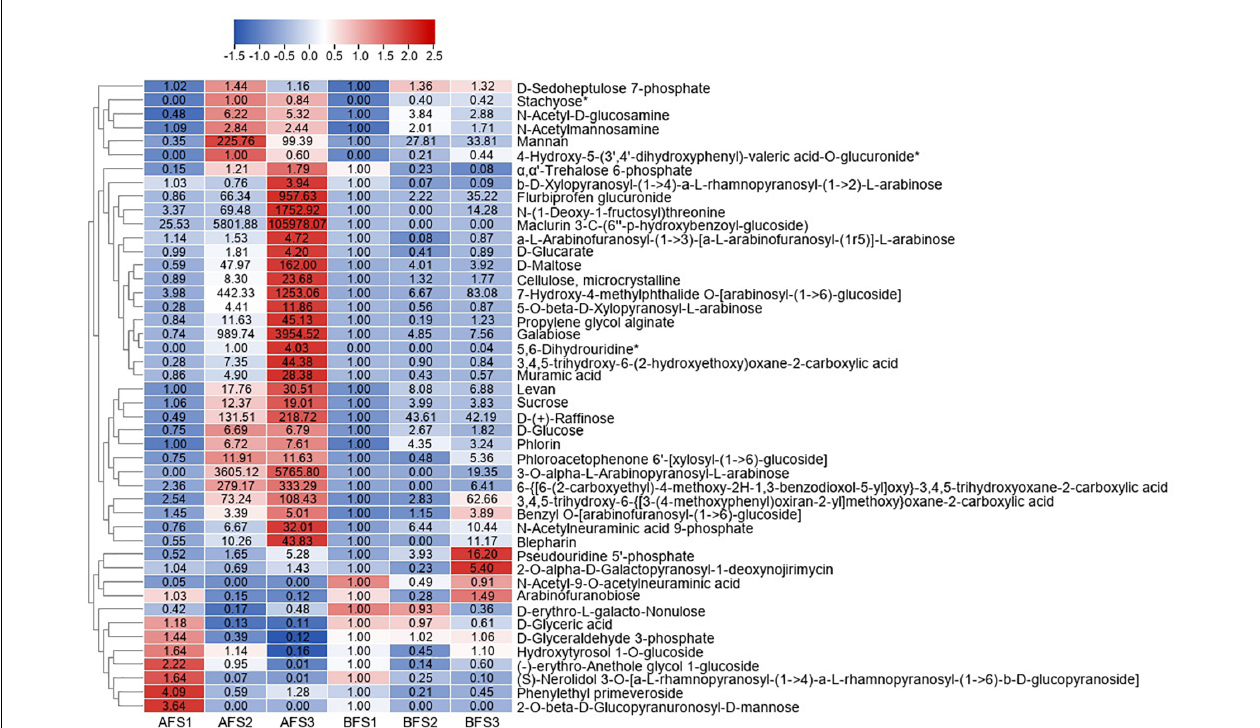
FIGURE 2 | Heatmap of the DAMs of sugar metabolites during three fruit developmental stages of the oriental melon cultivars A and B. The three “A” fruit development stages are AFS1, AFS2, and AFS3, and three “B” fruit development stages are BFS1, BFS2, and BFS3. The DAMs were selected based on a FC value ≥ 2 and FC value ≤ 0.5 in any comparison groups of AF and BF. The FC values are displayed in the heatmap, which used the data of BFS1 as the calibrator, while the metabolites with asterisks used the data of AFS2 as the control (due to no detection in BFS1).